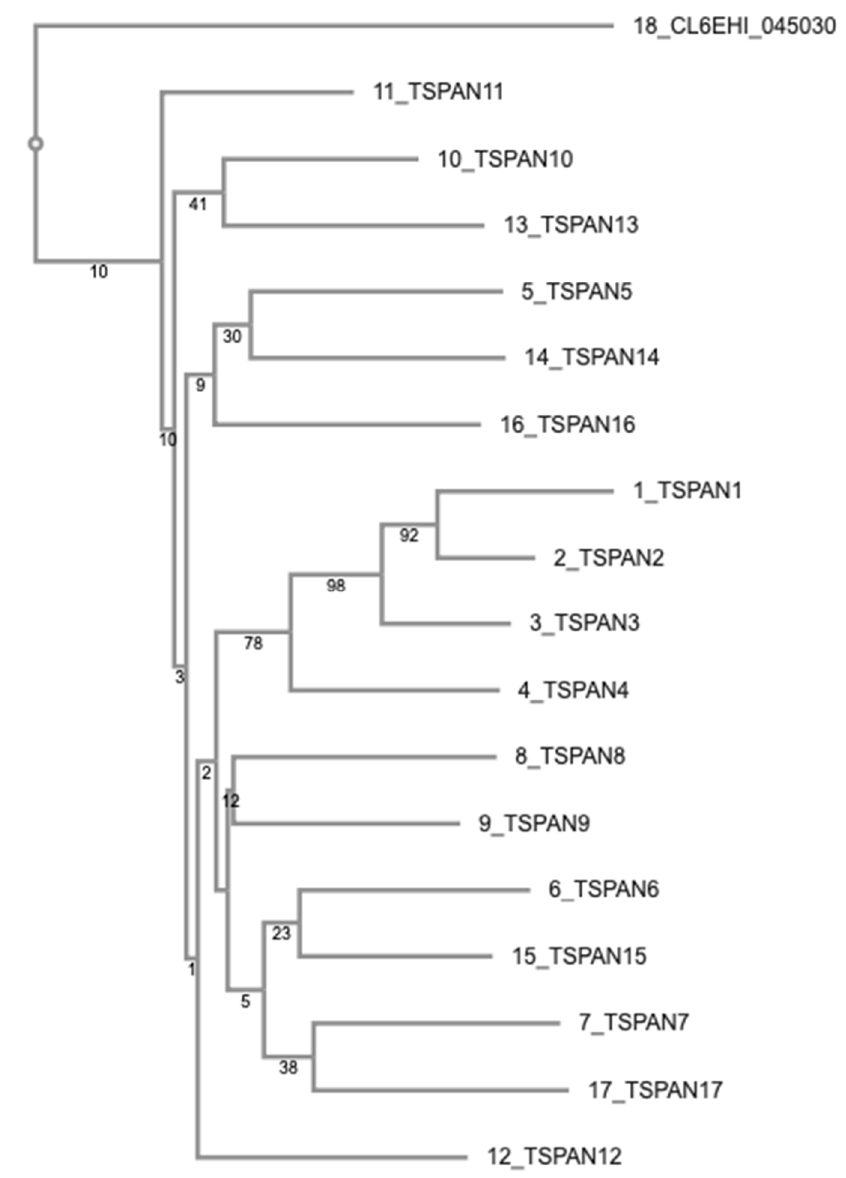
Figure 1. Phylogenetic tree of 17 tetraspanins in E. histolytica . Bootstrap support values are placed at each branch point.